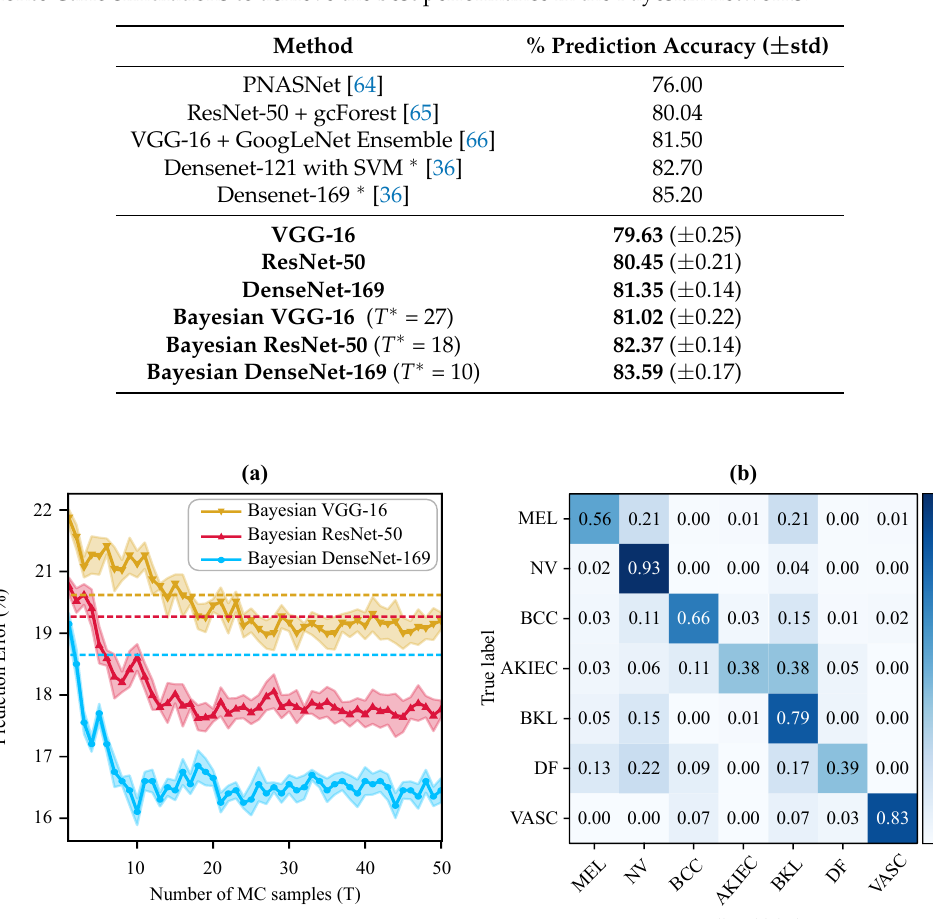
Figure 4. Test predictive performance of the Bayesian models in skin lesion classification. ( a ) Test prediction error of the Bayesian frameworks at different numbers of MC iterations (i.e., forward passes). The best result is achieved via Bayesian DenseNet-169 at 10 MC sampling. The shaded area around the curves shows one standard deviation. The dotted lines show the test error for the best standard (i.e., non-Bayesian) counterparts in the same color. ( b ) Normalized confusion matrix of the Bayesian DenseNet-169 on test data with 10 MC